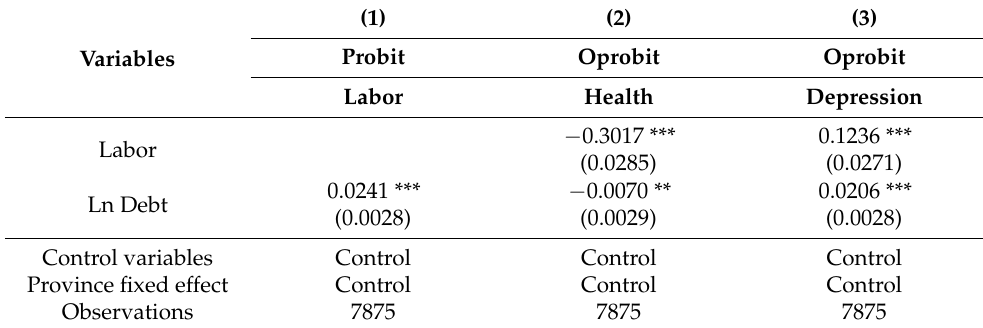
Table 11. Household debt, labor, and health of the elderly. (1) (2) (3) Probit Oprobit Variables